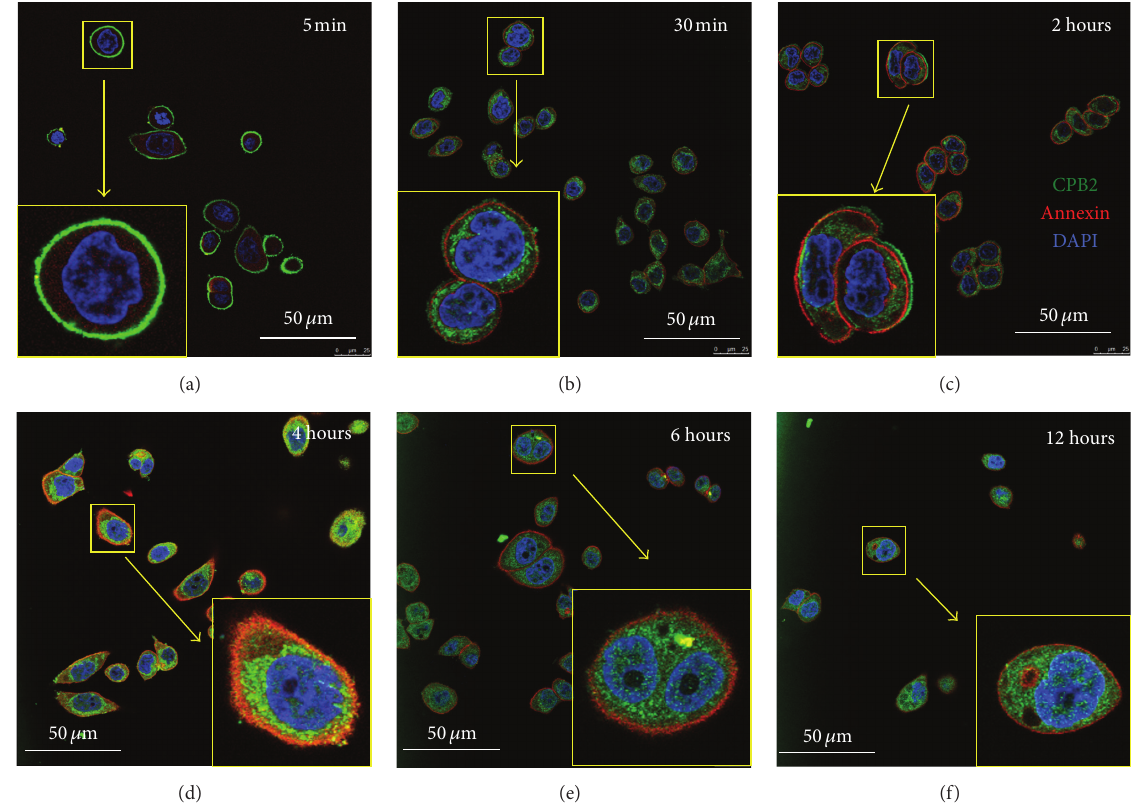
Figure 7: Ability of rCPB2 binding to NCM460 cells characterized by an immunofluorescent assay. NCM460 cells were incubated with rCBP2 at concentration of 15 𝜇 g/mL for indicated times. The cells were then used for accessing rCPB2 protein and cell membrane with McAb 1E23 to CPB2 (1: 100) and rabbit polyclonal antibody to Annexin A2 (1:200), respectively. FITC-labeled donkey anti-mouse IgG (1: 500) and Rhodamine- (TRITC-) conjugated goat anti-rabbit IgG (1: 250) were used as secondary antibodies for visualizing respective proteins of interest. DAPI was used for nuclear staining. (a–f) Representative images of immunofluorescent staining for cells incubated with rCPB2 at indicated times of 5min (a), 30min (b), 2 h (c), 4 h (d), 6h (e), and 12 h (f). The results showed that rCPB2 was able to bind to the membrane of NCM460 cell and translocate into the cytoplasm of cells. Insets were the enlarged boxed regions of respective images in (a–f). Bars in (a–f): 50 𝜇